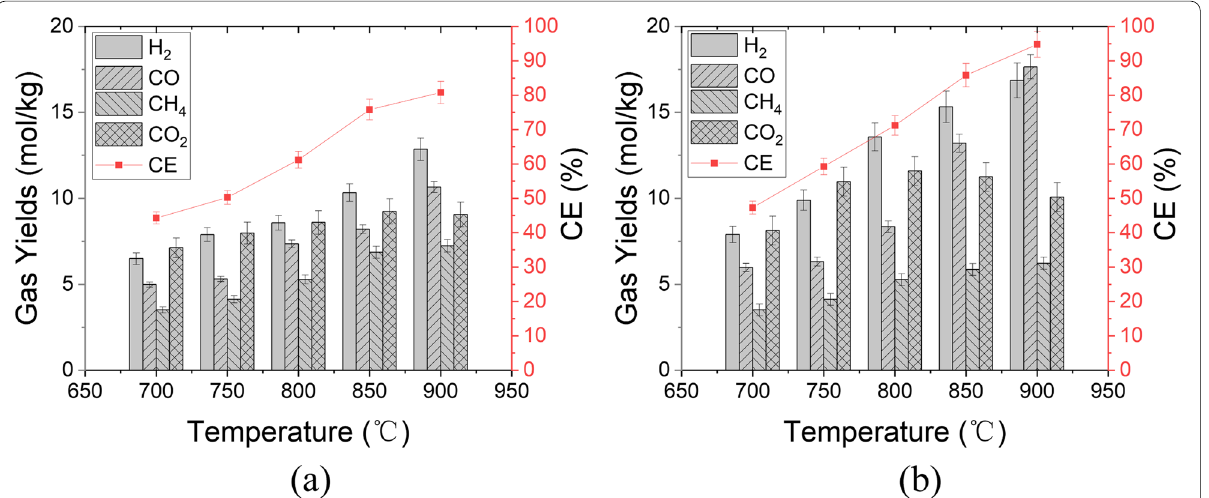
30 min; K 2 CO 3 : Biomass 1) a argon atmosphere; = =